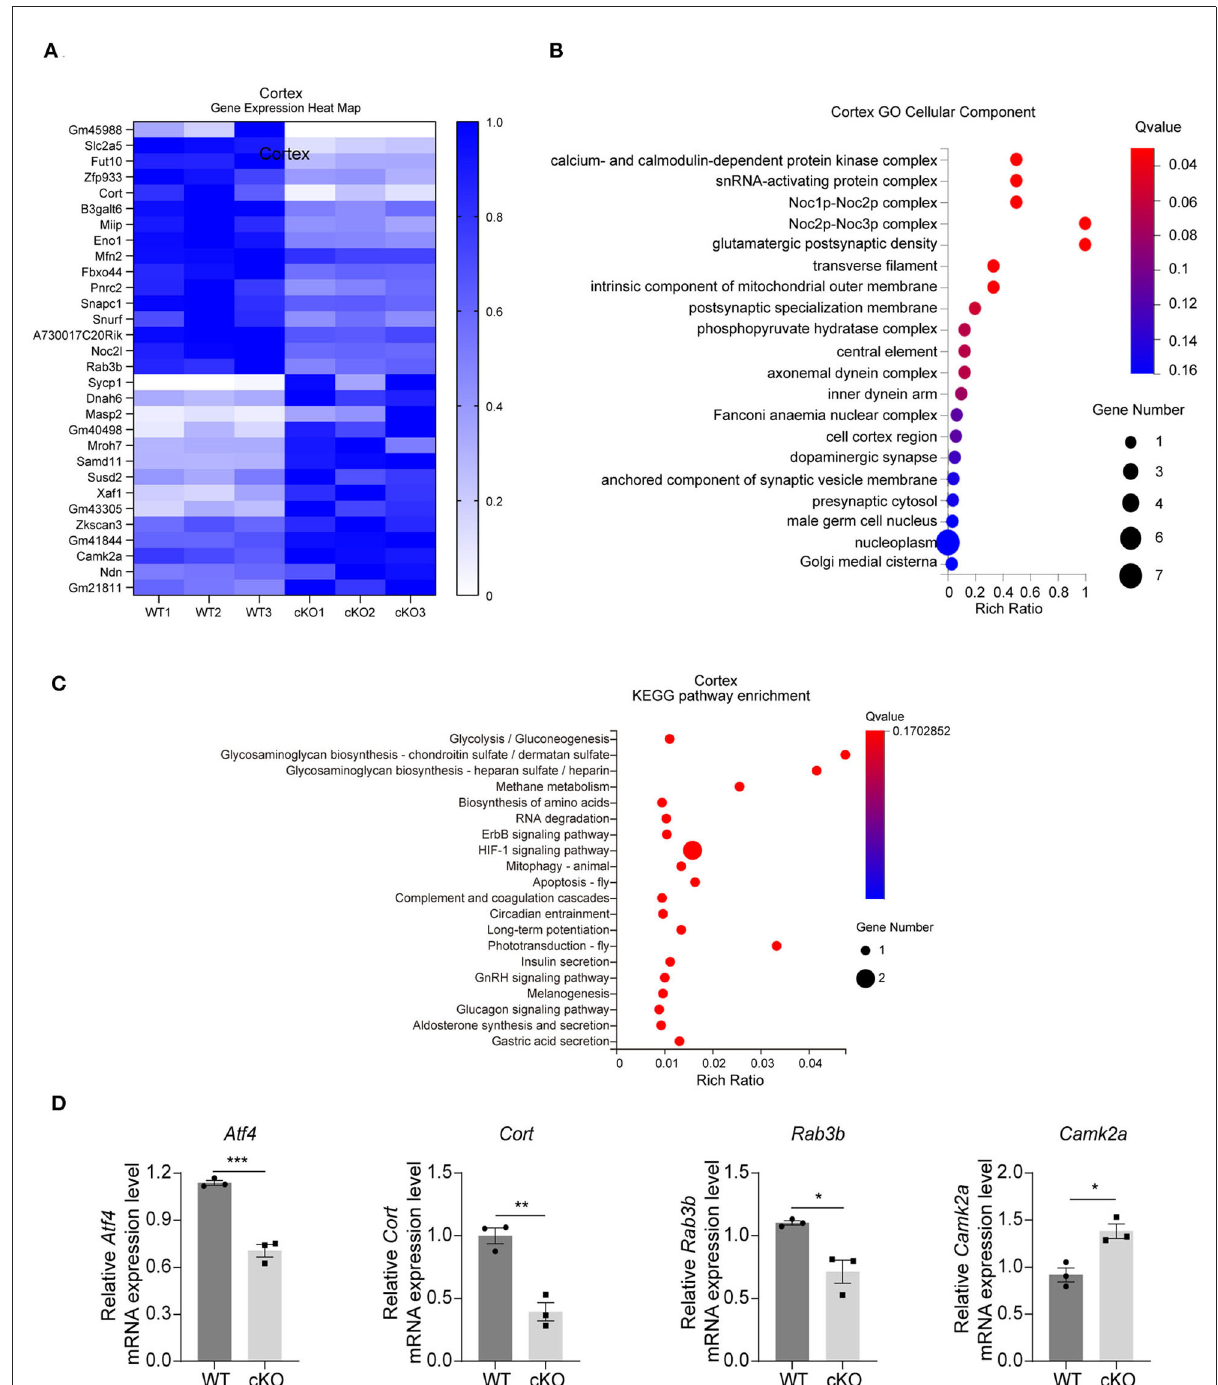
FIGURE3 Changes in signaling pathways and expression profiles of genes in the cerebral cortex of the MAD2B cKO mice. (A) Heat map of DEGs in the cerebral cortex; the deeper the purple, the higher the expression. (B) GO analysis of cellular components in the cerebral cortex, n = 3, p < 0.05. The size of the bubble indicates the gene number, the color depth indicates the Q-value, and the rich ratio indicates the gene number/the total gene number in the y-axis item. (C) KEGG pathway enrichment analysis of DEGs in the cerebral cortex, n = 3, p < 0.05. The size of the bubble indicates the gene number, the color depth indicates the Q-value, and the rich ratio indicates the gene number/the total gene number in the y-axis item. (D) qRT-PCR identification of DEGs in the cerebral cortex ( Atf4 p = 0.0006, t = 9.942; Cort p = 0.0032, t = 6.322; Rab3b p = 0.0148, t = 4.106; and Camk2a p = 0.0123, t = 4.334), n = 3, * p < 0.05, ** p < 0.01, *** p < 0.001. All data are displayed as means ±